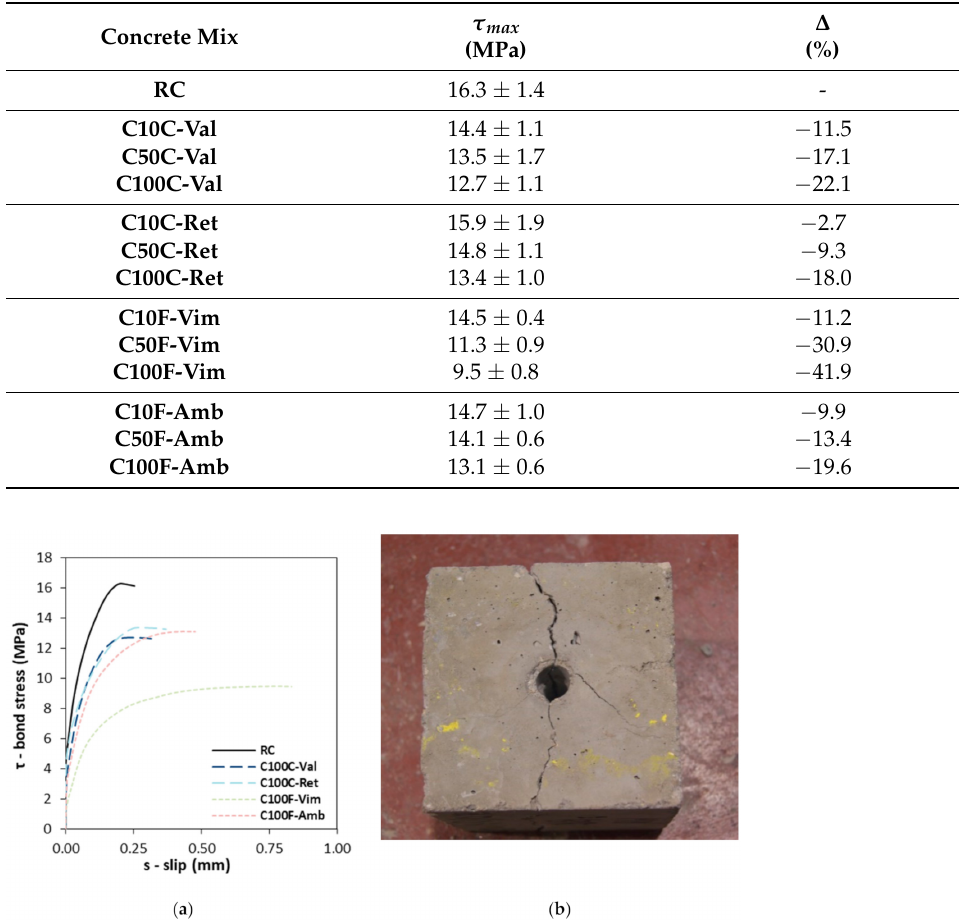
Table 8. Bond strength of the concrete mixes with RA from CDW.